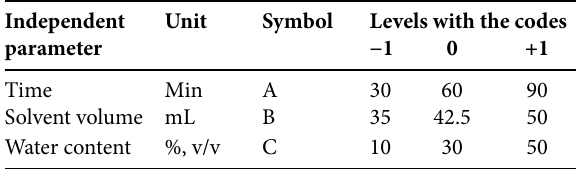
Table 3. Operation parameters of the UAE of Rosa canina L. fruits